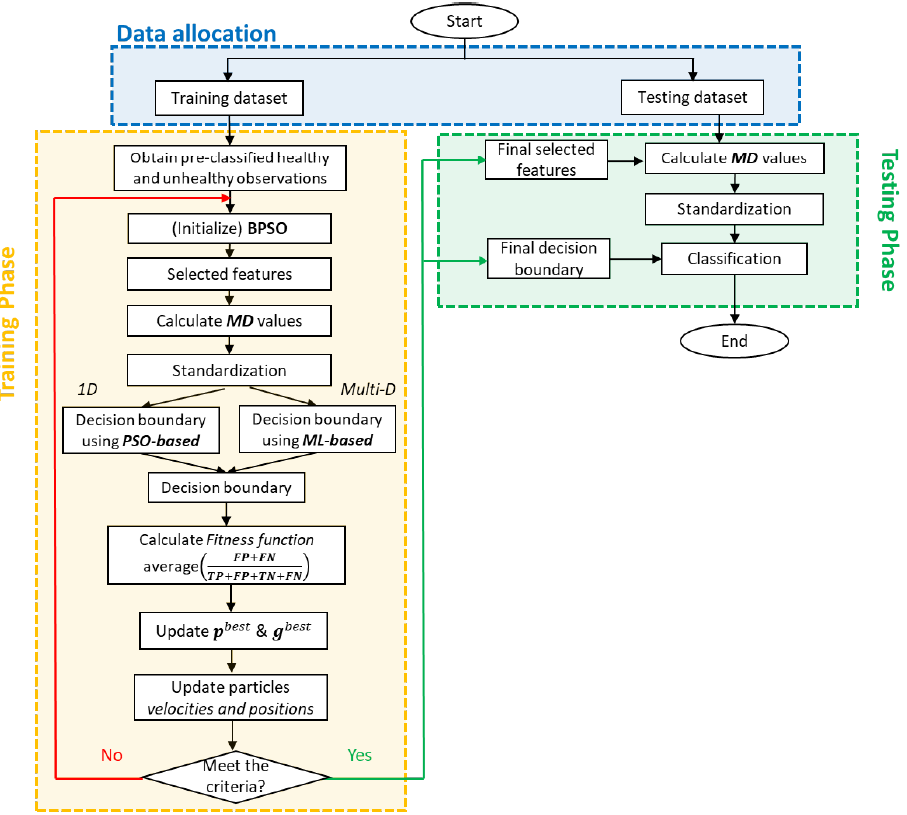
Figure 1. The schematic of the integrated Mahalanobis classification system (IMCS) algorithm.